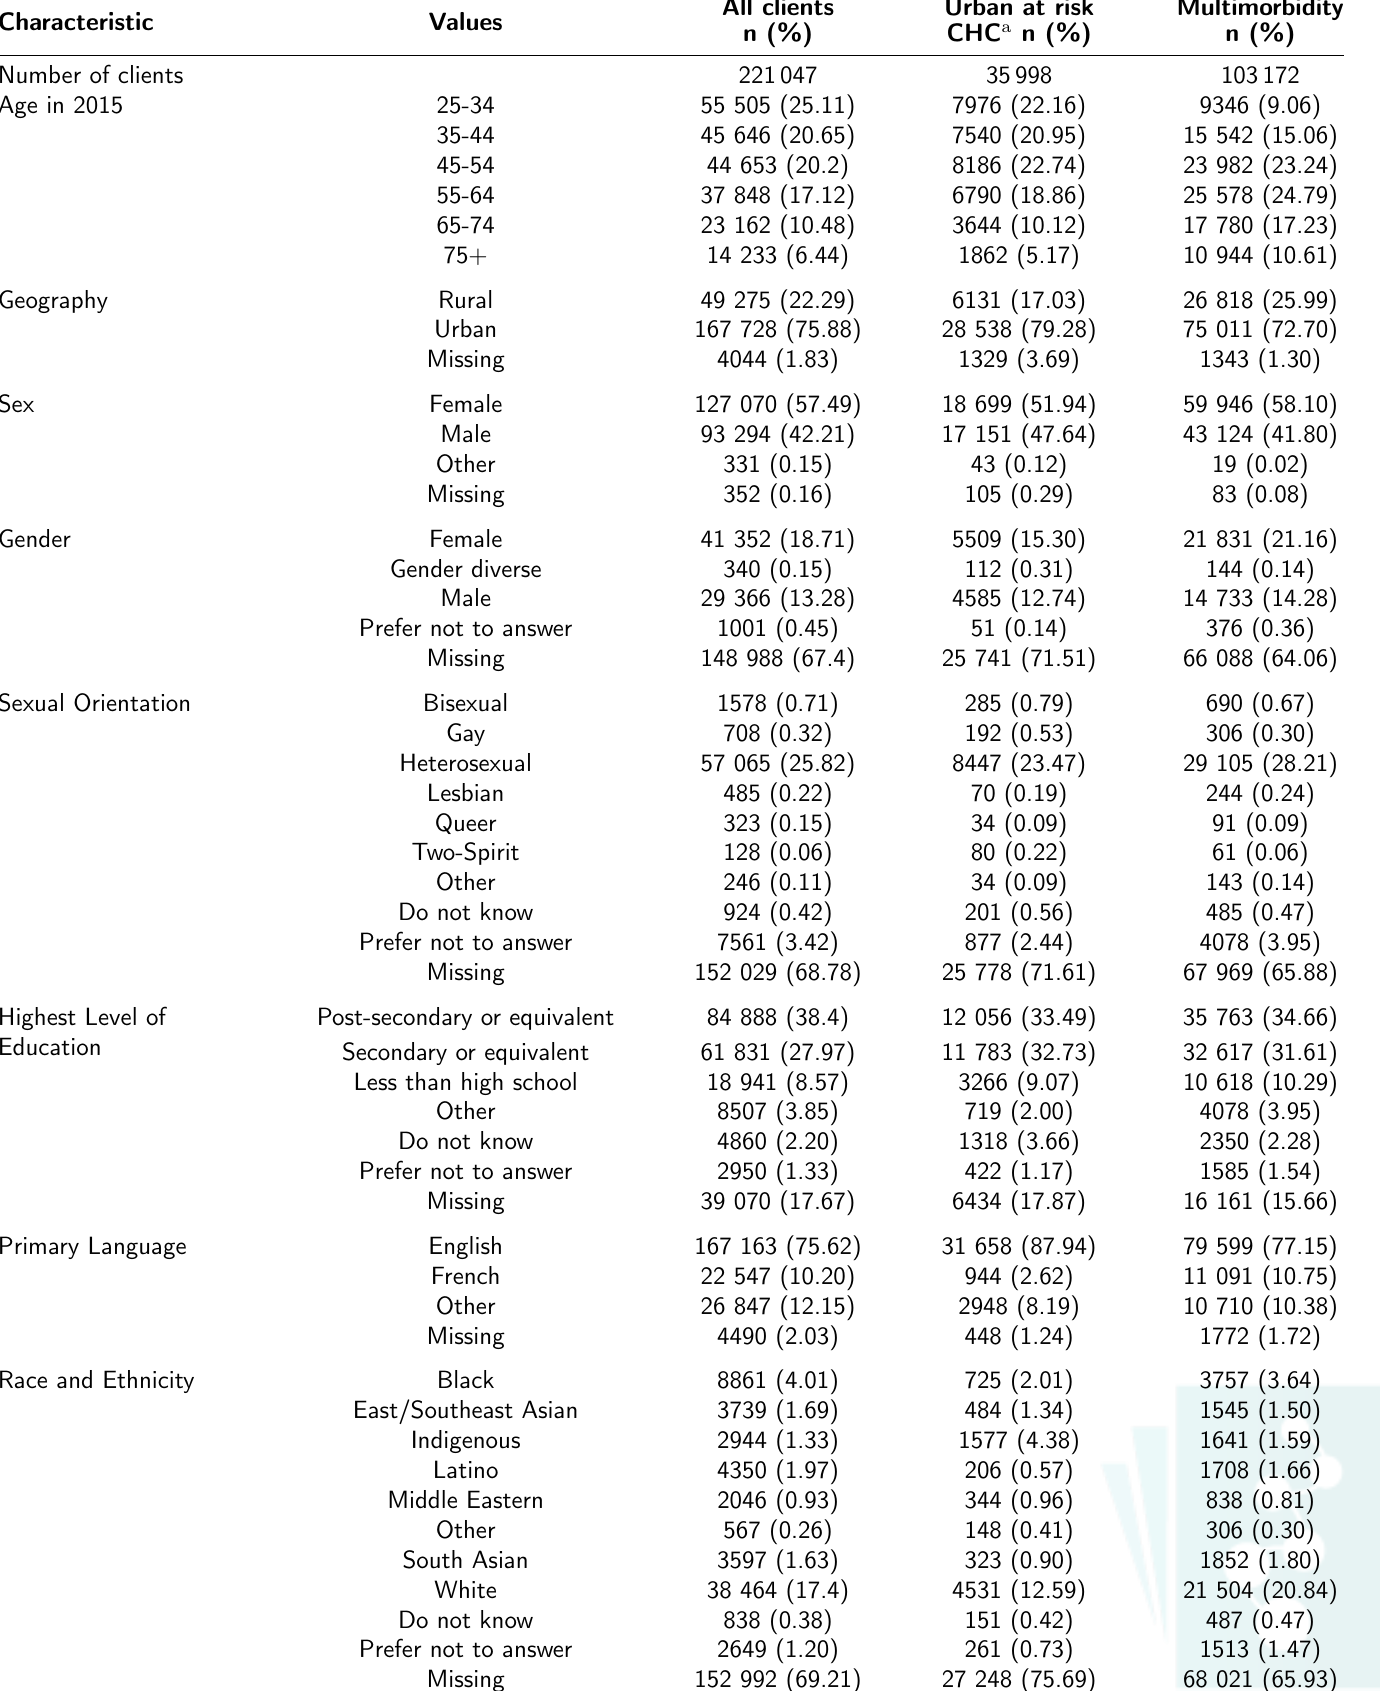
Table 1: Sociodemographic